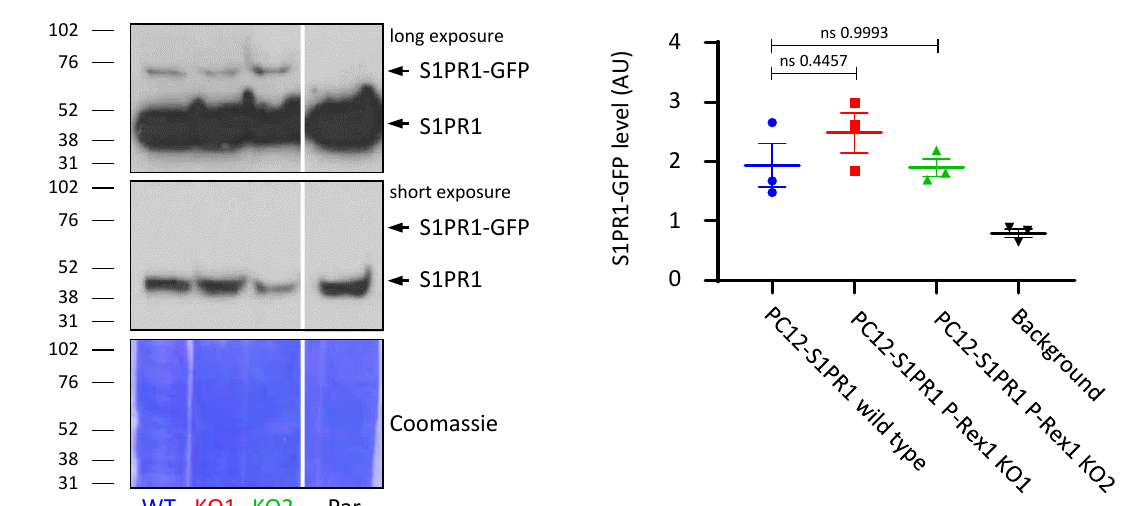
Figure 1. Generation of P-Rex1-deficient PC12-S1PR1 cells. ( A ) Representative wide-field fluorescence image of PC12-S1PR1 cells. Shown is the GFP signal from stably expressed S1PR1-GFP. ( B ) P-Rex1 domain structure, exon structure of the Figure 1: Generation of P-Rex1 deficient PC12-S1PR cells catalytic DH domain in rat, highlighting exon 4 which we targeted to generate P-Rex1 deficiency in PC12-S1PR1 cells by CRISPR/Cas9-mediated gene editing. ( C ) In vitro quality testing of the sgRNA selected for CRISPR/Cas9-mediated targeting of P-Rex1. The DNA gel shows efficient cutting of the target DNA by Cas9 in the presence of the sgRNA. ( D ) cDNA and amino-acid sequence showing the region of interest from exon 4 to the start of exon 7 of rat P-Rex1, from wild-type and P-Rex1-deficient PC12-S1PR1 cells. Blue and black letters mark different exons. CRISPR/Cas9 gene editing inserted a single nucleotide into exon 4 of P-Rex1, causing frameshift and premature Stop. ( E ) Western blot analysis of wild-type and P-Rex1-deficient PC12-S1PR1 cell lines for P-Rex1 and P-Rex2 expression; Coomassie staining of the membrane was used to control for protein loading. ( F ) P-Rex1 deficiency did not affect S1PR1 levels in PC12-S1PR1 cell lines. ‘WT’ denotes wild-type PC12-S1PR1 cells. ‘KO1’ and ‘KO2’ denote successfully targeted P-Pex1-deficient PC12-S1PR1 cell lines. ‘Par’ denotes parental PC12 cells without S1PR1-GFP. The left-hand panel shows representative S1PR1 Western blots and the Coomassie-stained membrane. The white line denotes cropping of irrelevant lanes from the membrane. The right-hand panel shows quantification by densitometric analysis of blots from three independent experiments. Data are presented as the mean ± SEM; each symbol represents one experiment. Statistical analysis involved one-way ANOVA with Sidak’s multiple comparisons test; ‘ns’ denotes data which were not significantly